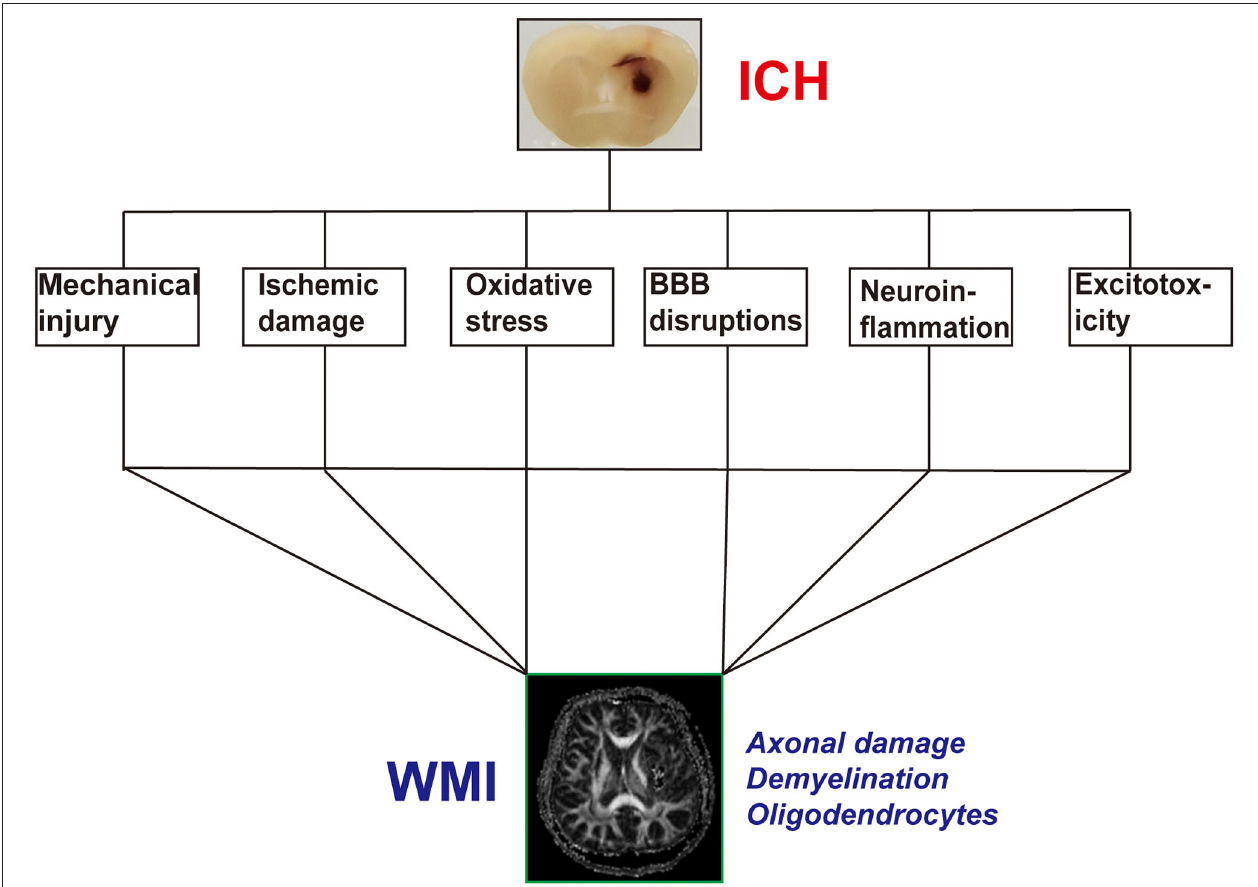
FIGURE 1 | The possible pathophysiological factors of white matter injury (WMI) after intracerebral hemorrhage (ICH).